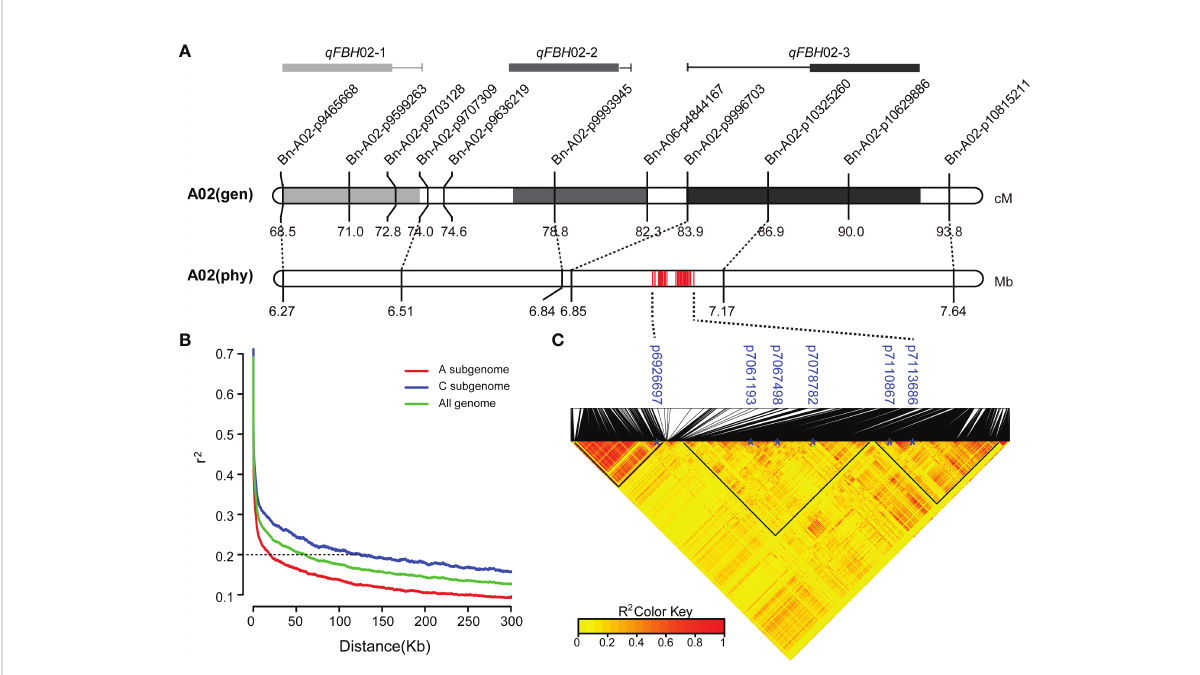
FIGURE 4 Co-localization of qA02.FBH . (A) The genetic location corresponds to the physical location. (B) Linkage disequilibrium (LD) decay of the (A, C) subgenomes and the whole genome. (C) LD heatmap surrounding the peak on A02. The black triangles represent closely linked